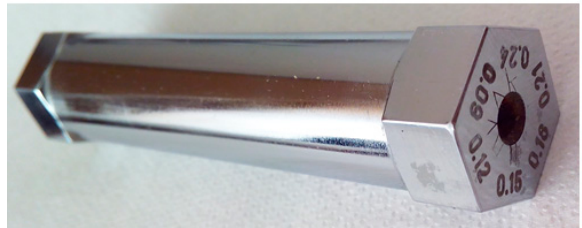
Figure 1. The film applicator used for making thin composite films.